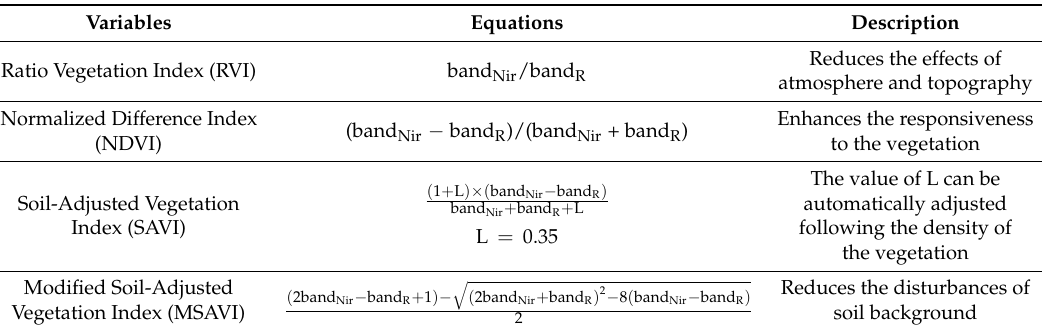
Table 1. Vegetation indices and equations used in this